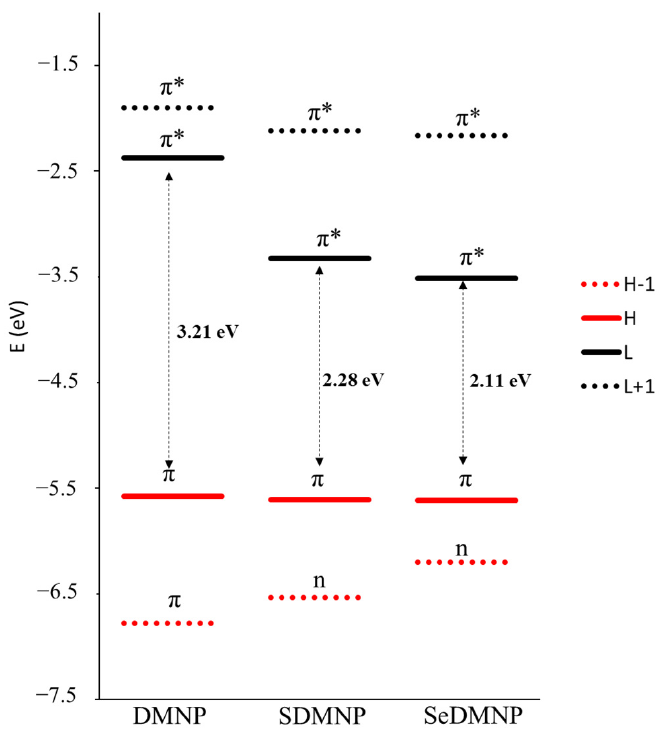
Figure 4. Gouterman frontier molecular orbital energies for DMNP, SDMNP, and SeDMNP. Upon sulfur-for-oxygen replacement, the H → L lowest energy band undergoes a bathochromic shift, detected at 603 nm, and its π → π * nature has a considerable